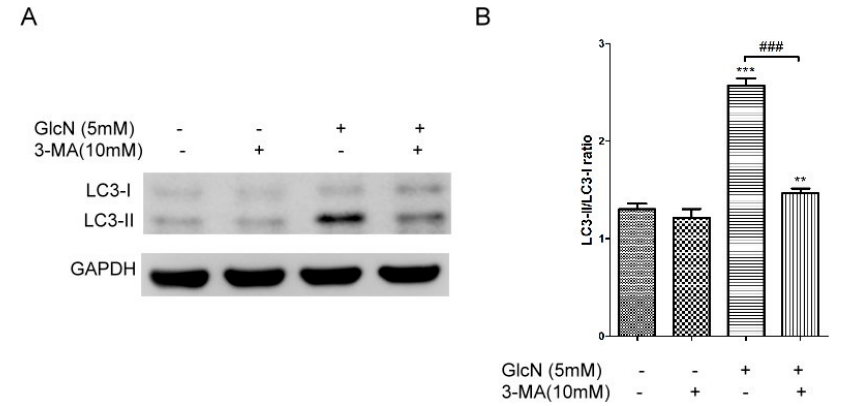
Figure 5. 3-Methyladenine (3-MA) inhibited glucosamine (GlcN)-induced autophagy in ARPE-19 cells. ( A ) The cells were pretreated with or without 3-MA (10 mM) for 1 h followed by co-treatment with or without GlcN (5 mM) for another 18 h. Whole-cell lysates were prepared and analyzed with immunoblotting using anti-LC3 and anti-GAPDH antibodies. ( B ) Optical density of the Western blot bands for LC3-I, LC3-II, and GAPDH was analyzed. The results are represented as the mean ± SEM. The differences in the LC3-II/LC3-I ratios between groups were compared using ANOVA, and Tukey’s test was used for post hoc analysis; ns, not significant; ** p < 0.01 versus the control group; *** p < 0.001 versus the control group; ### p <